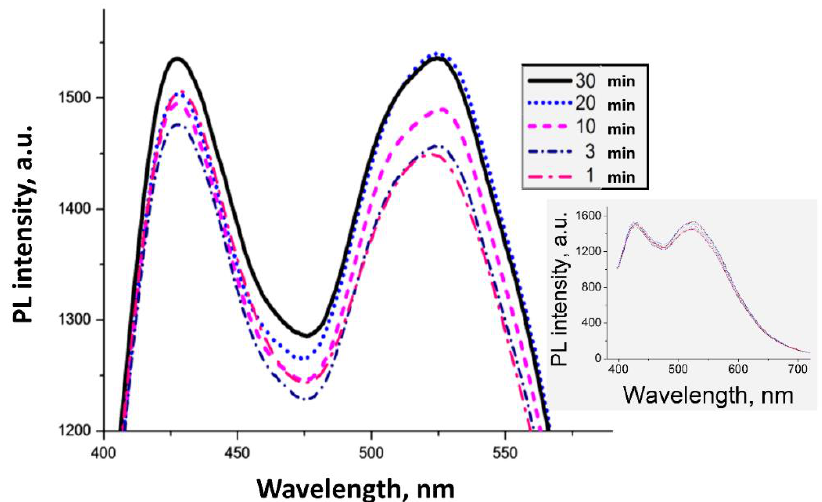
Figure 3. PL spectra of (H 3 BO 3 +8-Hq) solution in IPA, depending on the exposure time at 50 °C (λ ext = 365 nm).